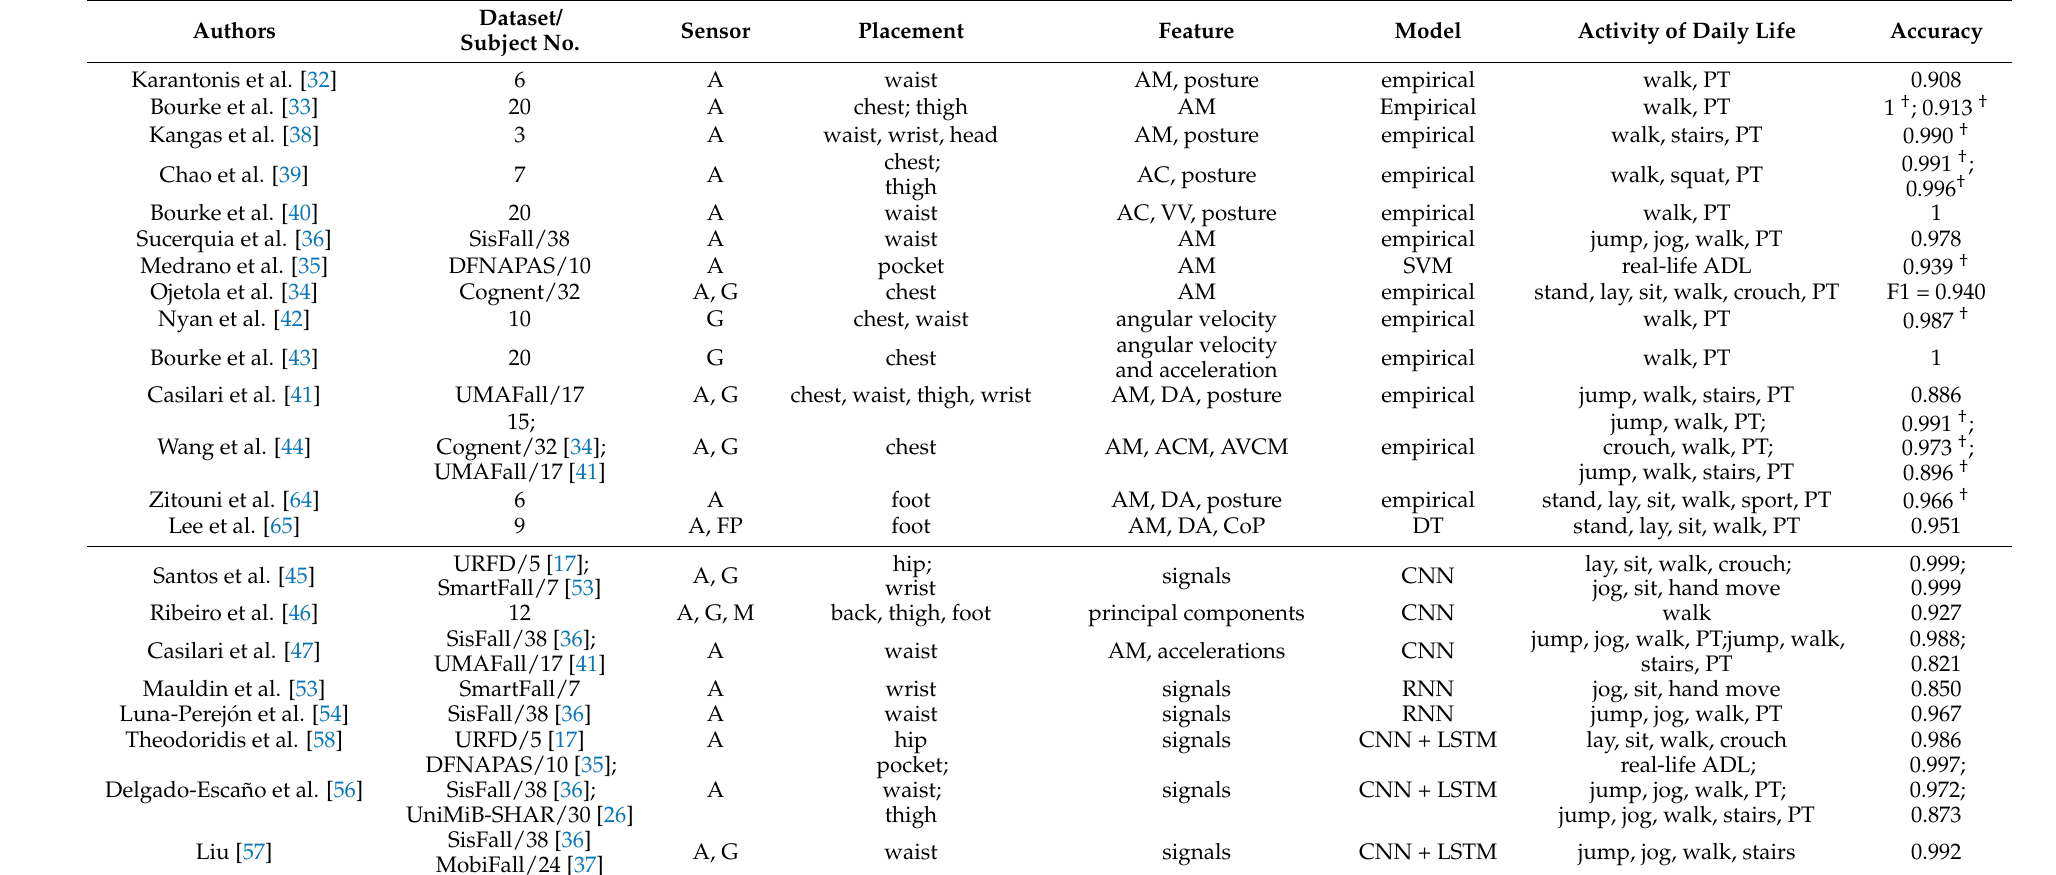
Table 2. Methods for fall